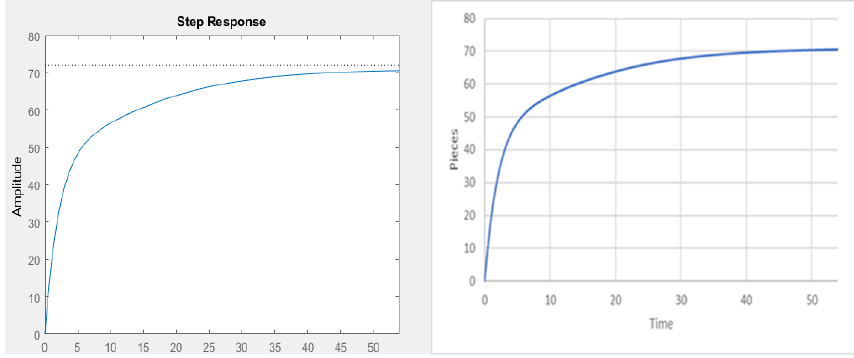
Figure 21. Cutting process output with a step input and Stella software.